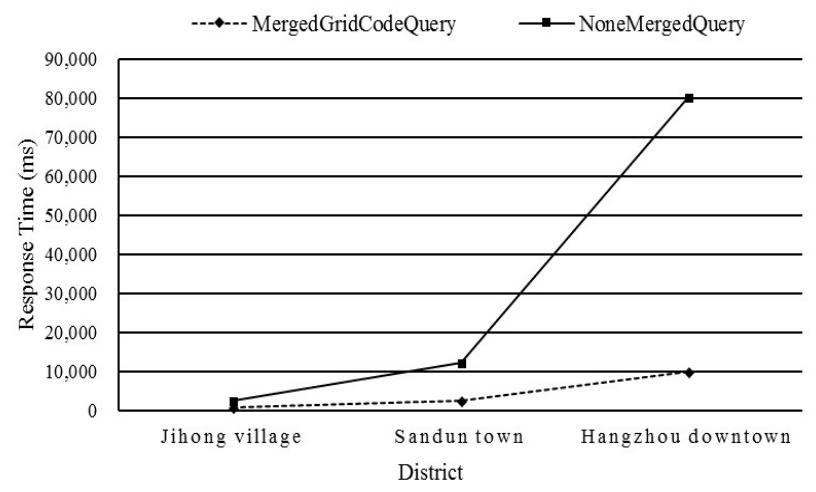
Figure 19. Intersection query efficiency with the optimized strategy on merging grid cell codes.